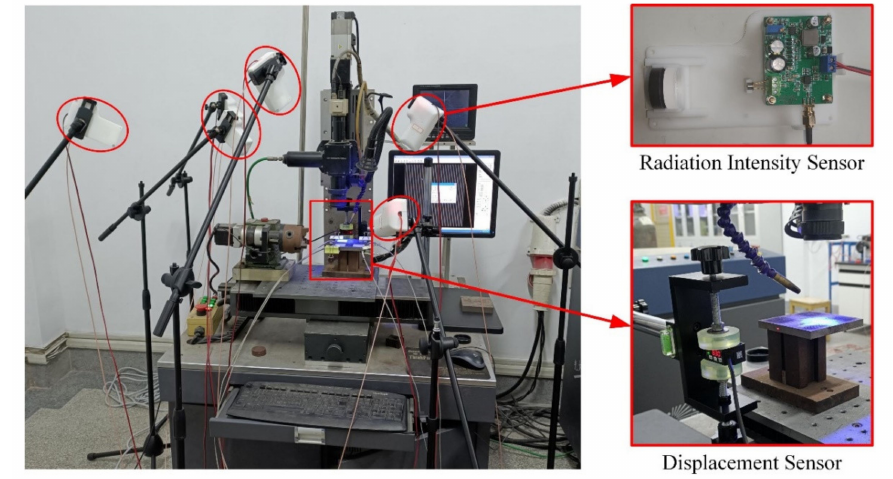
Figure 7. Test system in the